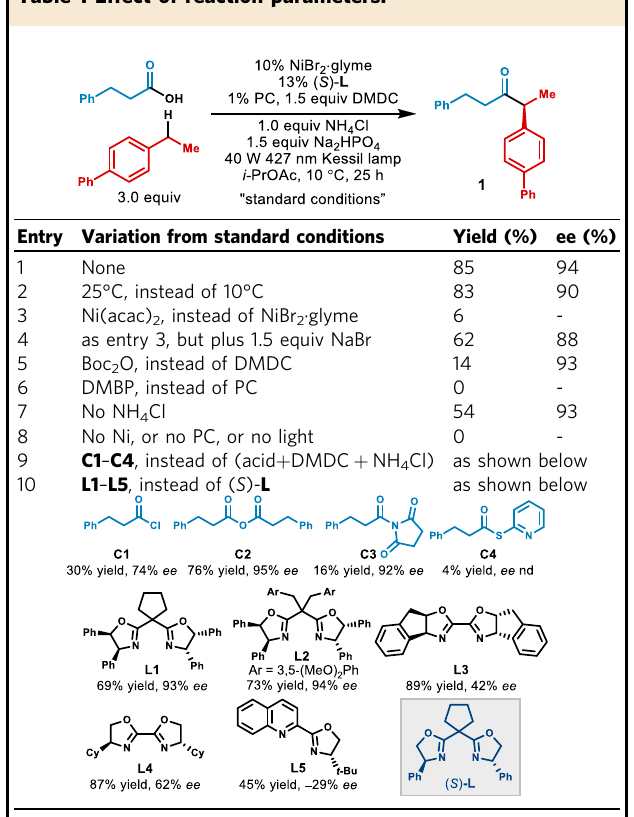
Table 1 Effect of reaction